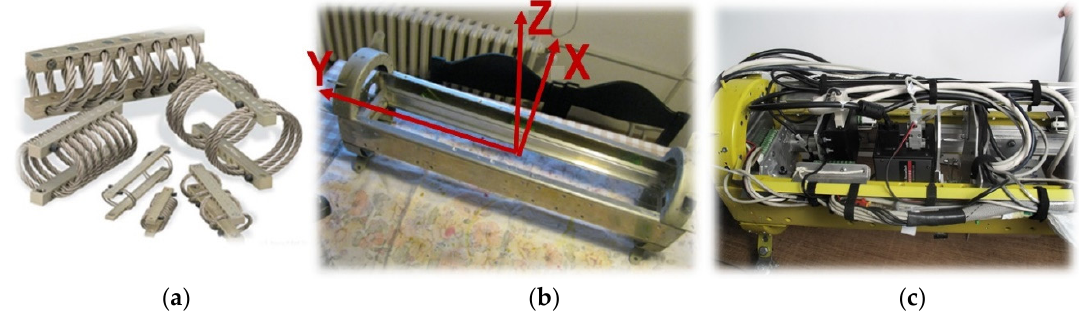
Figure 9. ( a ) Wire rope vibration dampers (ITT, 2019), ( b ) coordinate axes in sensor pod, ( c ) wire rope dampers installed in the sensor